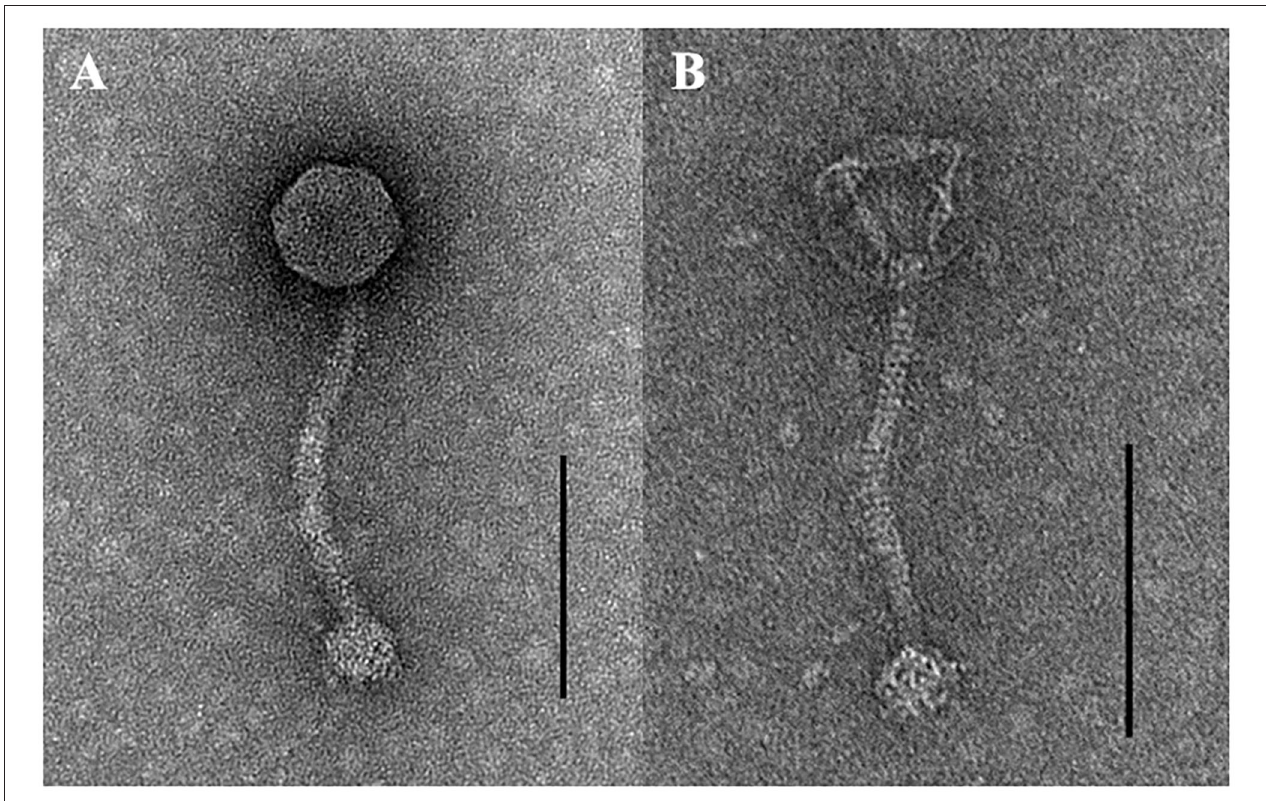
FIGURE 1 | Transmission electron microscopy images of (A) pSp-J and (B) pSp-S. Scale bar = 100nm.